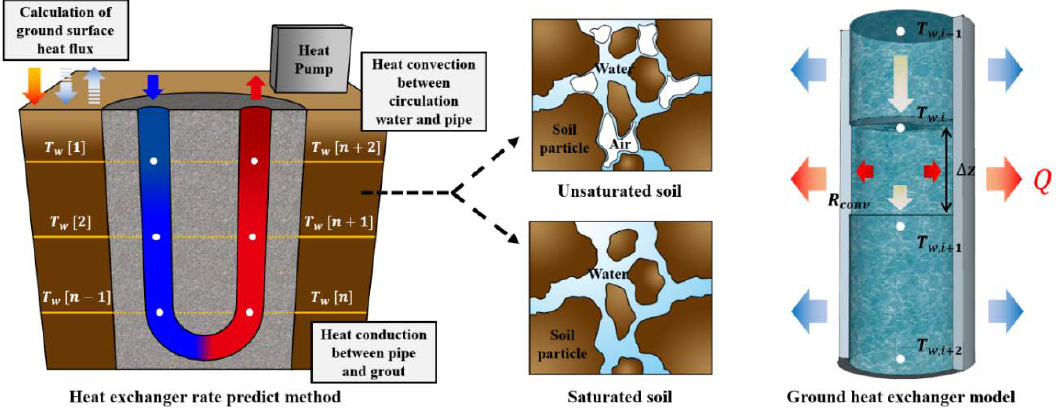
Figure 2. Outline of analysis method.